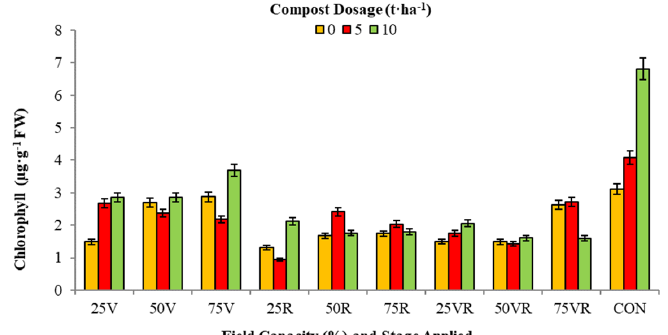
Figure 14. Effect of interaction of water regime, treatment stage and compost dosage on chlorophyll content of okra leaf at 8 weeks The 25, 50 and 75% represent field capacity; V (vegetative), R (reproductive), and VR (vegetative and reproductive) represent the stage at which the deficit was applied. Data in the interaction analyzed with Least Squares Means, and means separated with LSD.